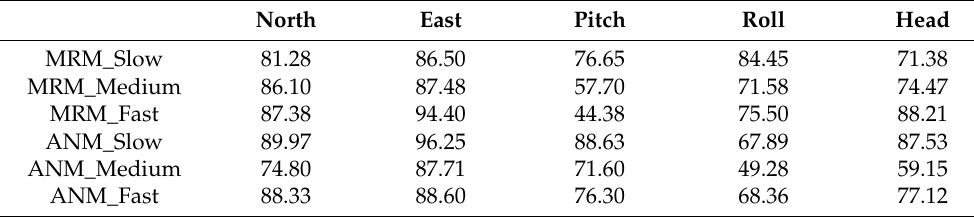
Table 3. Decrease ratio of RMSE coefficient of each mode (%).